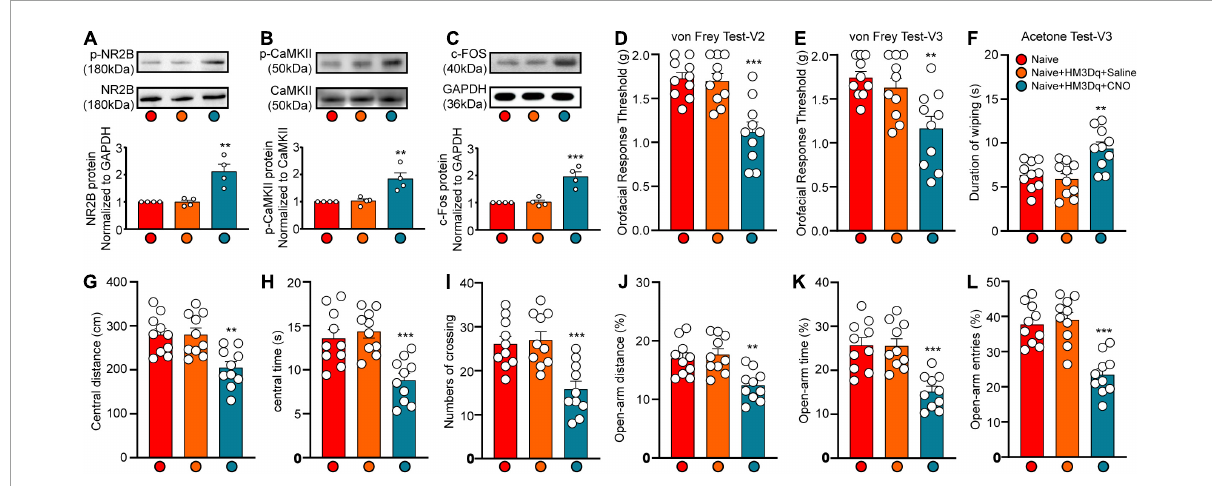
FIGURE6 Chemicogenetic activation of bilateral LHb neurons triggered orofacial pain and anxiety-like behavior. The c-FOS, p-NR2B and p-CaMKII protein expression of the Hb at 45 min after CNO injection was shown by the representative blots (A–C) . The mechanical and cold allodynia were triggered by bilateral pAOV-CaMKII-HM3D(Gq)-EGFP-3FLAG injection into the LHb neurons and the subsequent CNO administration (D–F) . The central distance (G) , central time (H) , and numbers of crossing (I) in the OFT and the percentage of open-arm distance (J) , open-arm time (K) , and open-arm entries (L) in EPM test were significantly reduced by the activation of LHb neurons by HM3Dq-CNO. N = 10 mice per group, ** p < 0.01, *** p < 0.001 vs. the Naive+HM3Dq+Saline